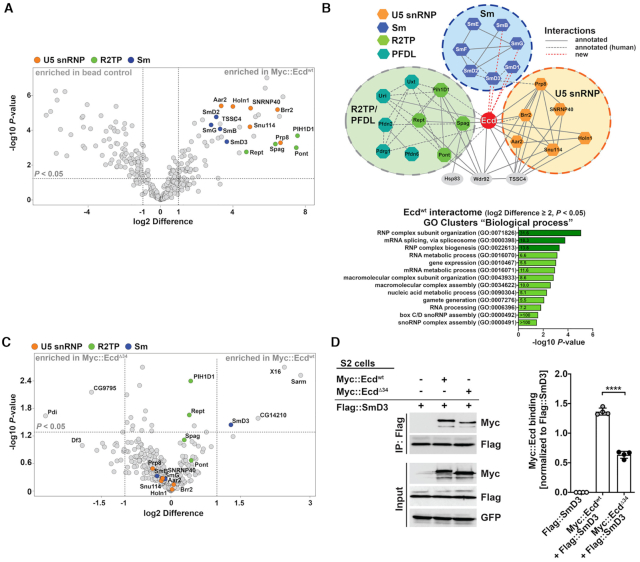
The heptameric Sm ring protein SmD3 interacts with Ecd. (A) The volcano plot depicts Ecd-specific interactome identified by LC-MS/MS analysis based on pull-down of Myc::Ecdwt protein from Drosophila S2 cell lysate with an anti-Myc-specific antibody. 61 proteins enriched in Myc::Ecdwt IP samples relative to control (S2 cells not expressing Myc::Ecdwt) (|log2 difference| ≥ 1 and FDR < 0.05) are located within the outlined area. Specific interaction partners including Sm proteins (blue), U5 snRNP proteins (orange), and R2TP components (green) are highlighted. (B) Visualization of a simplified Ecd interaction network comprising Sm (blue), U5 snRNP (orange) and R2TP complex (green) proteins using Cytoscape. Annotated interactions are shown with full or dashed gray lines, new interactions with red dashed lines. The bar graph depicts functional GO clusters enriched (fold enrichment ≥ 5, FDR < 0.05, noted within the bars) among the Myc::Ecdwt interacting proteins (|log2 Difference| ≥ 2 and FDR < 0.05). GO terms linked to RNP assembly and RNA splicing are highlighted in dark green. (C) The volcano plot depicts results of comparative LC–MS/MS analysis showing differences in proteins pulled down with Myc::Ecdwt and Myc::EcdΔ34 from Drosophila S2 cell lysates. Sm proteins (blue), U5 snRNP proteins (orange), and R2TP components (green) are highlighted. Note that the binding of SmD3 to EcdΔ34 protein is markedly reduced. (D) Representative western blot and quantifications of independent IP assays in Drosophila S2 cells confirm decreased binding of Flag::SmD3 to Myc::EcdΔ34 compared to Myc::Ecdwt protein. Proteins were pulled down by anti-Flag magnetic beads. Data represent means ± SD, n = 4. Unpaired two-tailed Student's t-test was used to determine significance, ****P < 0.0001. See also Supplementary Figure S4 and Supplementary Dataset S1.